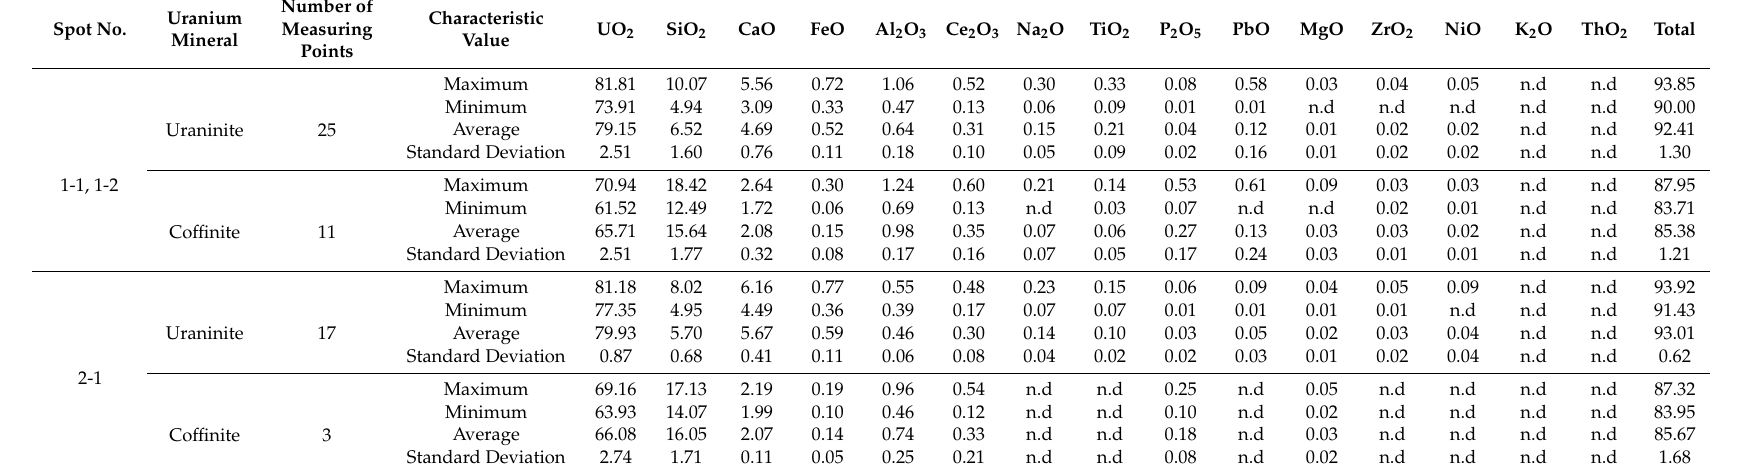
Table 1. The statistical characteristic value of oxide concentrations (wt%) of uranium mineral from the MHK uranium deposit (n.d = not detected; Spot no. “1-1” represents the number of target and grain,